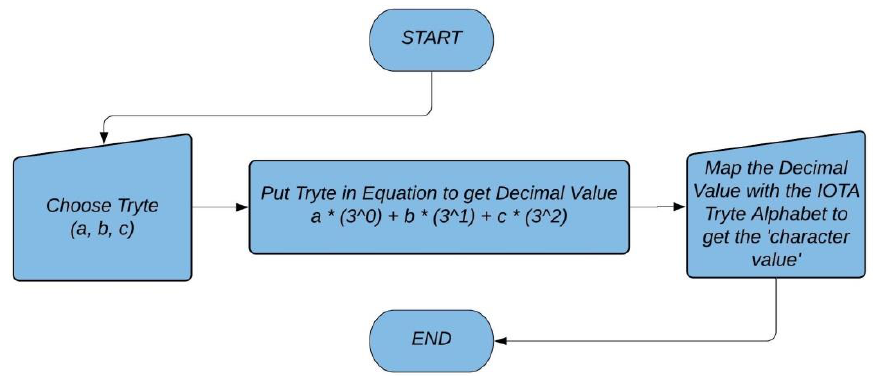
Figure 5. Flowchart for finding the Tryte Alphabet.